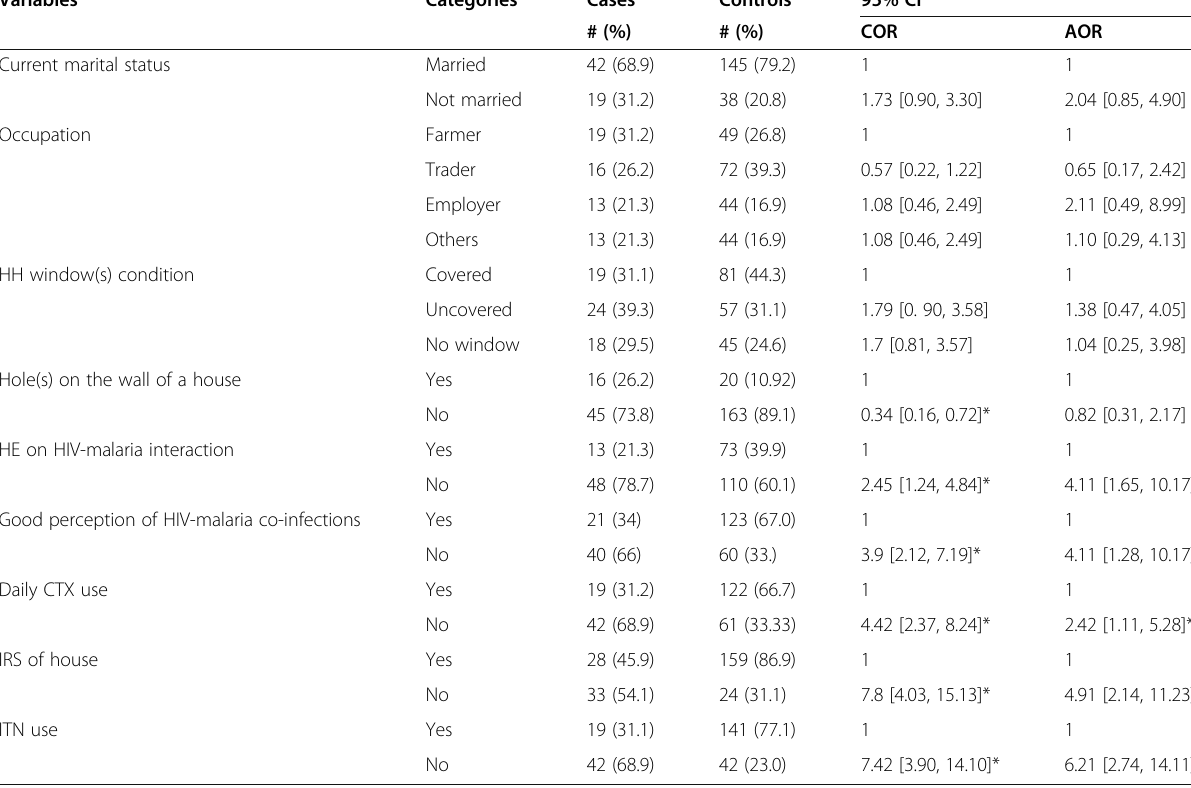
Table 2 Bivariable logistic regression analysis of determinant factors for HIV-malaria co-infection among people living with HIV attending Shewarobit Health Center ART Clinic, Shewarobit district, Amhara Region, Ethiopia 2018